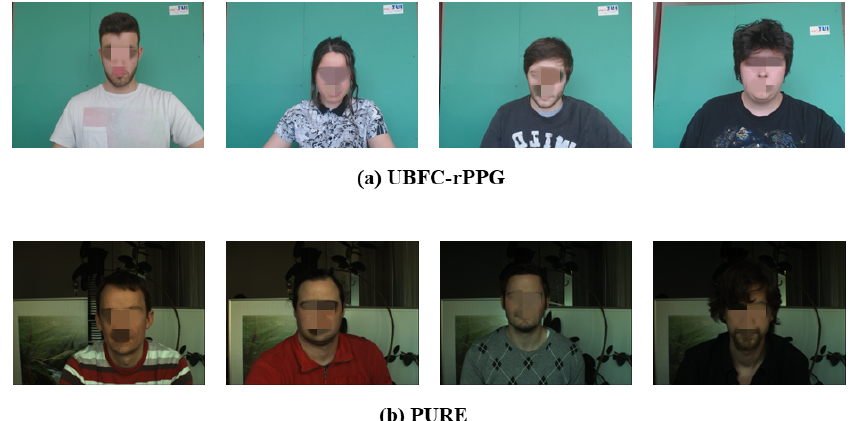
Figure 12. Example images from the two datasets used in this